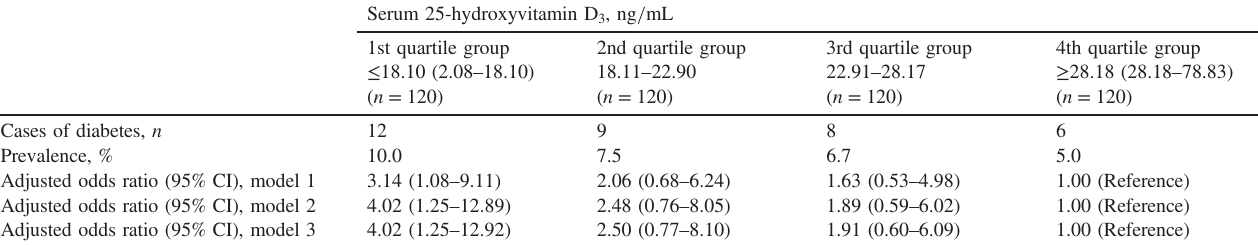
Table 2. Odds ratios for diabetes in participants grouped by serum 25-hydroxyvitamin D 3 quartiles Serum 25-hydroxyvitamin D 3 , ng / mL